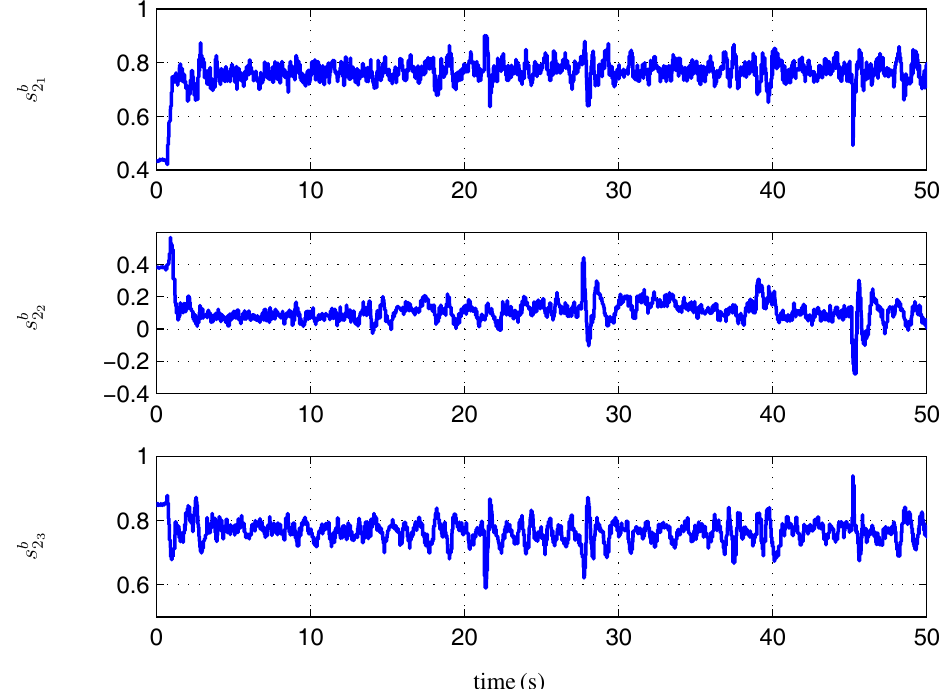
Figure 15. Control law of Corollary 2: the evolution of the magnetometer measurement s b